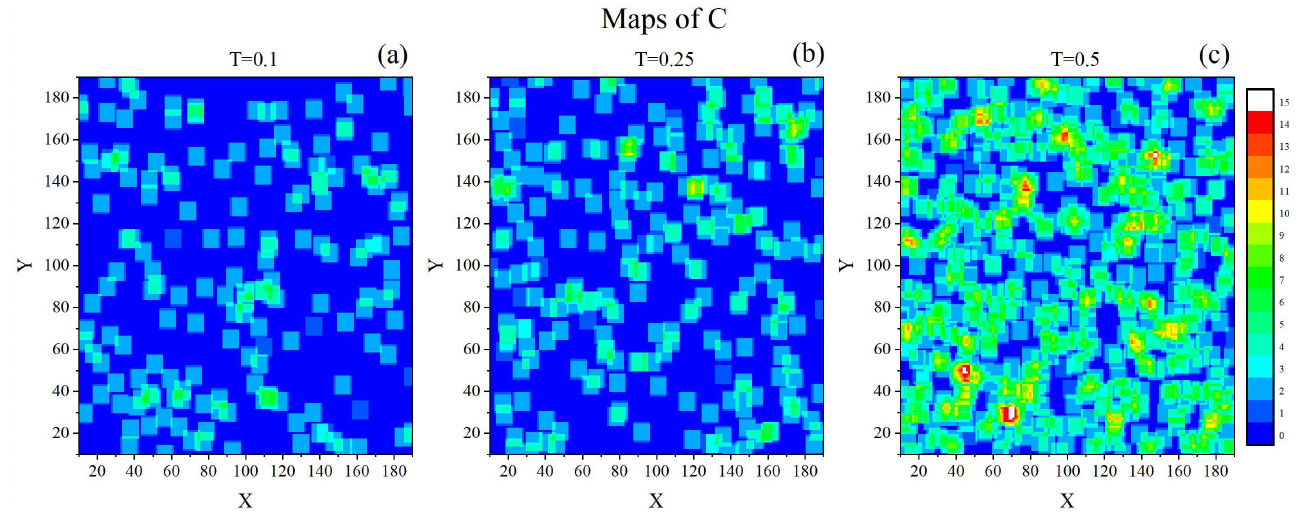
Figure 7. Instantaneous 2-dimensional maps of parameter C : T = 0.1 ( a ), T = 0.25 ( b ) and T = 0.5 ( c